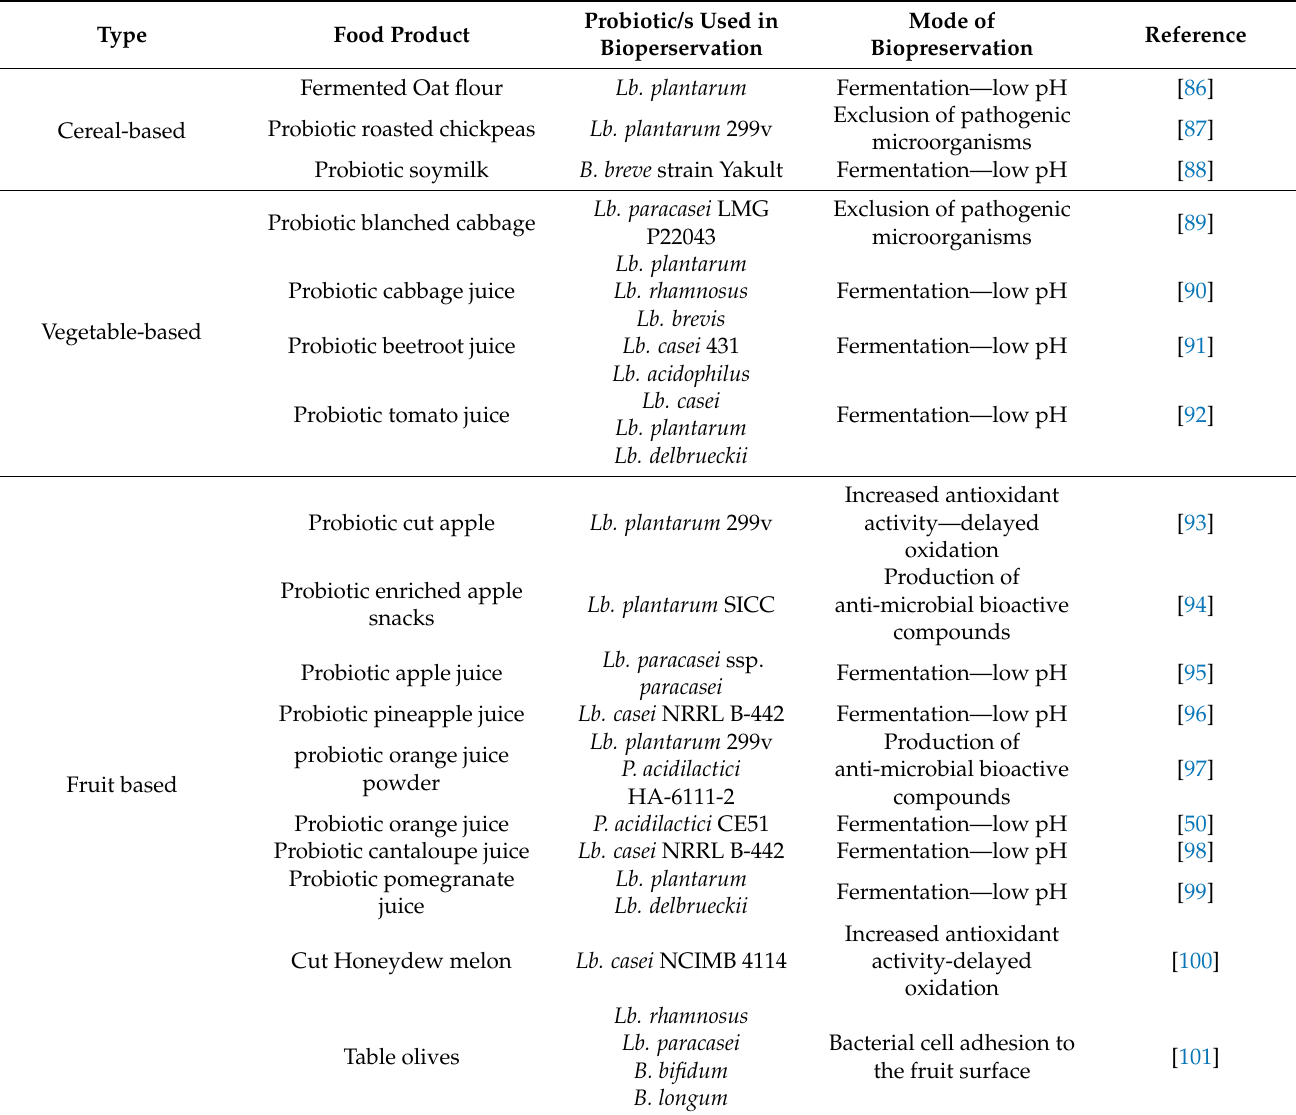
Table 2. Examples of probiotics used in biopreservation of vegetables, fruits, and other miscellaneous plant-based food